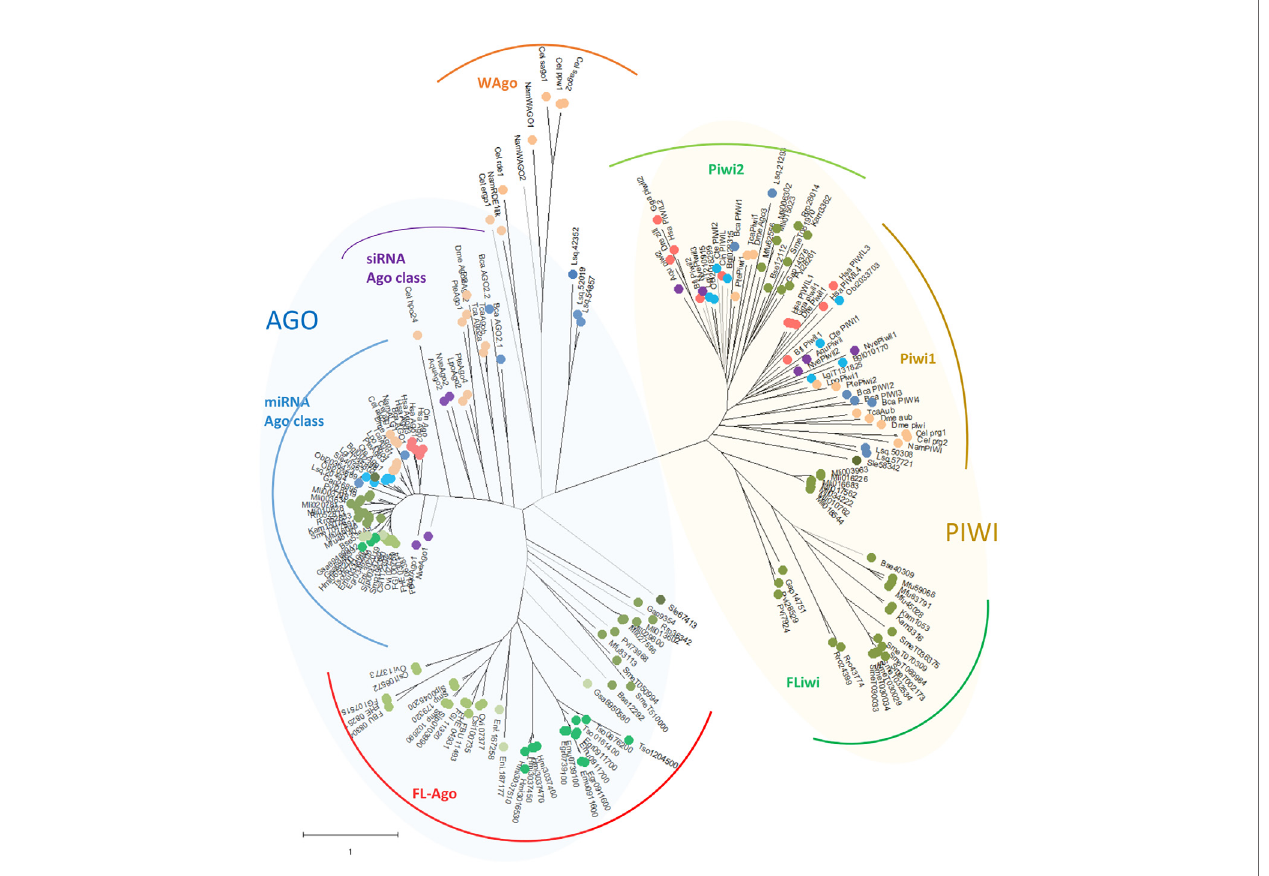
FIGURE 2 | Unrooted maximum likelihood phylogenetic tree of Argonaute proteins belonging to Deuterostomia ( (cid:129) : Hsa, Homo sapiens ; Gga, Gallus gallus ; Dre, Danio renio ; B fl , Branchiostoma fl oridae ; Cin, Ciona intestinalis ), Ecdysozoa ( (cid:129) : Cel, Caenorhabditis elegans ; Nam, Necator americanus ; Dme, Drosophila melanogaster ; Tca, Tribolium casteneum ; Pte, Parasteatoda tepidariorum ; Lpo, Limulus polyphemus ), Mollusca & Annelida ( (cid:129) : Obi, Octopus bimaculoides ; Bgl, Biomphalaria glabrata ; Lgi, Lottia gigantea ; Cte, Capitella teleta ), Rotifera & Gastrotricha ( (cid:129) : Bca, Brachionus calyci fl orus ; Lsq, Lepidermella squamata ) ‘ turbellaria ’ Catenulida ( (cid:129) : Sle, Stenostomum leucops ), ‘ turbellaria ’ Rhabditophora ( (cid:129) : Mli, Macrostomum lignano ; Pvi, Prostheceraeus vittatus ; Gap, Geocentrophora applanate ; Rro, Rhynchomesostoma rostratum ; Mfu, Monocelis fusca ; Kam, Kronborgia amphipodicola ; Bse, Bothrioplana semperi ), Monogenea ( (cid:129) : Eni, Eudiplozoon nipponicum ; Gsa, Gyrodactilus salaris ), Trematode ( (cid:129) : FBU, Fasciolopsis buski ; FHE, Fasciola hepatica ; FGI, Fasciola gigantica ; Ovi, Opisthorchis viverrini ; Clonorchis sinensis ; Smp, Schistosoma mansoni ; Sjp, Schistosoma japonicum ), Cestode ( (cid:129) : Hmi, Hymenolepis microstoma ; Tso, Taenia solium ; Emu, Echinococcus multilocularis ; Egr, Echinococcus granulosus ), Cnidaria & Porifera ( (cid:129) : Nve, Nemastella vectensis ; Aqu, Amphimedon queenslandica ). Black branches indicate SH-like approximate likelihood ratios ≥ 90. Arches indicates the subgroups of Argonautes (blue shaded) and Piwi (green shaded)